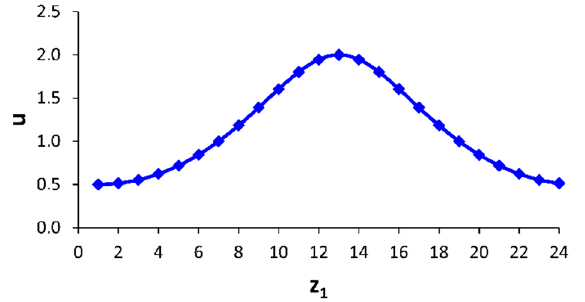
Figure 19. The course of changing gear ratio in the designed elliptical gear set.